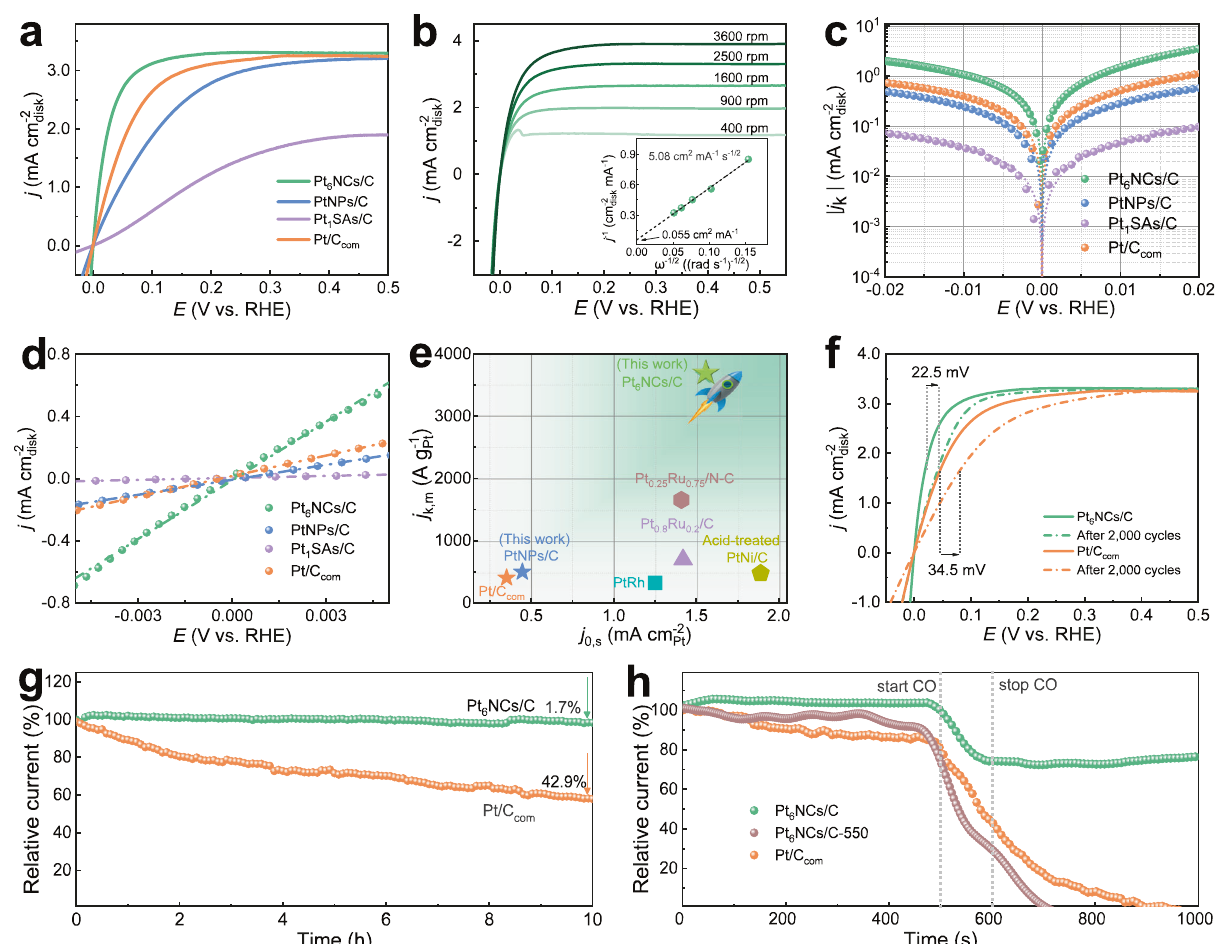
Fig. 3 HOR performance catalyzed by Pt-based catalysts. a HOR polarization curves of Pt 1 SAs/C, Pt 6 NCs/C, PtNPs/C, and Pt/C com catalysts in H 2 - saturated aqueous solution of 0.1 M KOH with a rotating rate of 2500 rpm at a scan rate of 5 mV s − 1 . b HOR polarization curves of Pt 6 NCs/C catalyst at different rotation rates. Inset: the Koutecky – Levich plot of Pt 6 NCs/C catalyst at an overpotential of 50 mV (vs. RHE). c Representative HOR/HER Tafel plots of kinetic current density ( j k ) for Pt 1 SAs/C, Pt 6 NCs/C, PtNPs/C, and Pt/C com catalysts. Symbols are calculated j k values, and lines are fi tted results based on the Volmer-Butler equation. d Linear current potential region around the equilibrium potential of HOR/HER of Pt 1 SAs/C, Pt 6 NCs/C, PtNPs/C, and Pt/C com catalysts conducted at a scan rate of 5 mV s − 1 with the rotation rate at 2500 rpm. The dotted lines indicate the linear fi tting of the data. e Comparison of the mass-speci fi c kinetic current ( j k,m ) at an overpotential of 50 mV (vs. RHE) and the area-speci fi c exchange current ( j 0,s ) with those of previous reports. f HOR polarization curves for Pt 6 NCs/C and Pt/C com before (solid lines) and after (dashed lines) accelerated durability test, respectively. g Relative current-time chronoamperometry response of Pt 6 NCs/C and Pt/C com catalysts in an H 2 -saturated aqueous solution of 0.1 M KOH at an overpotential of 60 mV (vs. RHE). h CO poisoning experiments of Pt 6 NCs/C, Pt 6 NCs/C-550, and Pt/C com catalysts at an overpotential of 100 mV (vs.